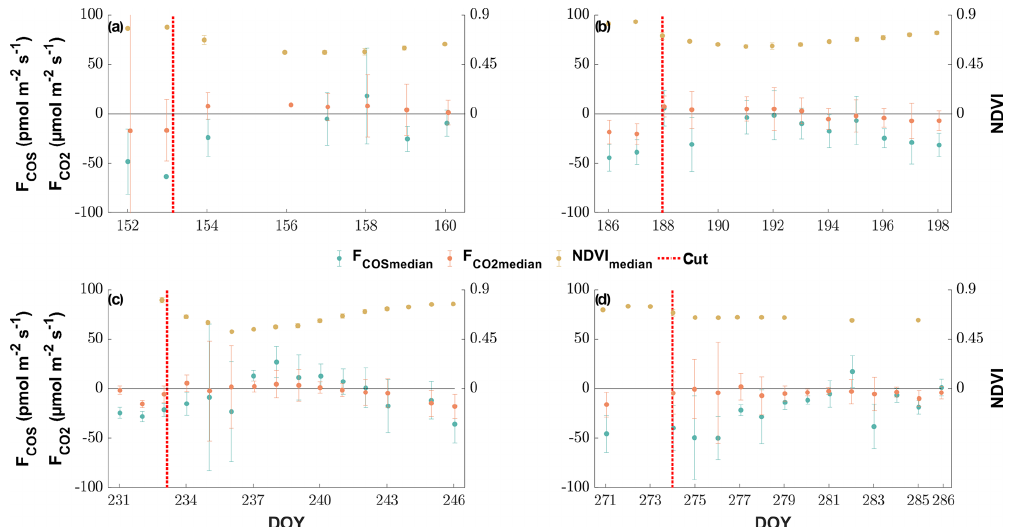
Figure 2. The response of the daily midday medians of NDVI (yellow circles), COS (green circles) and CO 2 (orange circles) ecosystem fluxes around the four cutting events (a–d) of the grassland. The error bars depict the respective median absolute deviations. The cuts are marked by a dashed red